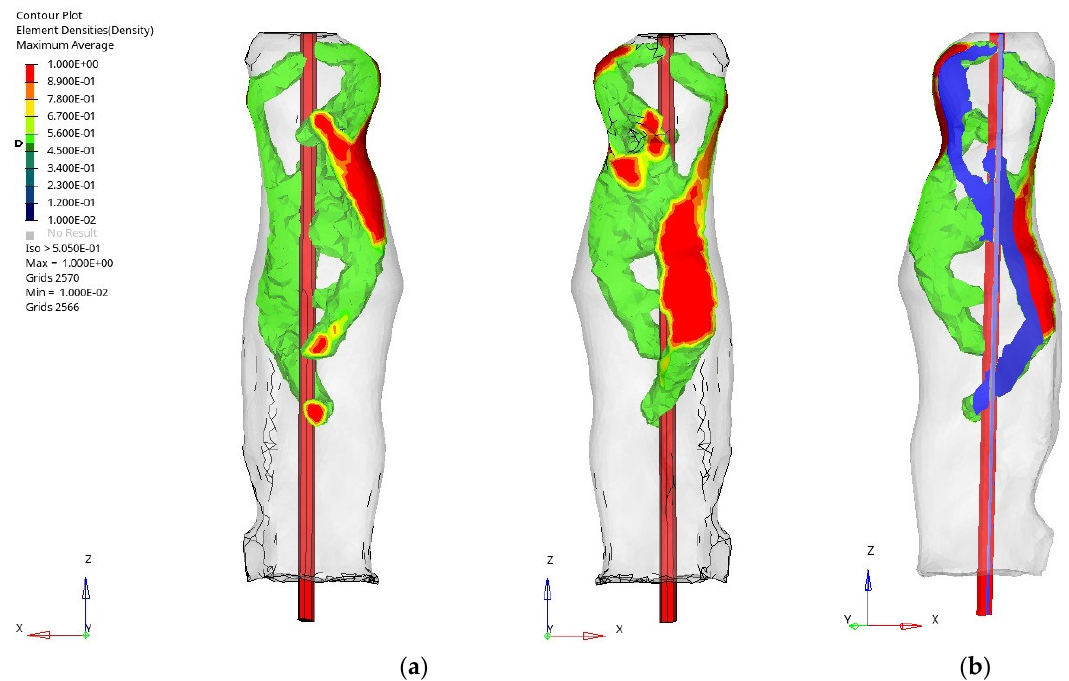
Figure 5. CB case: density distribution ( a ) Back and front View) ( b ) Two intersecting sectional views (in blue).